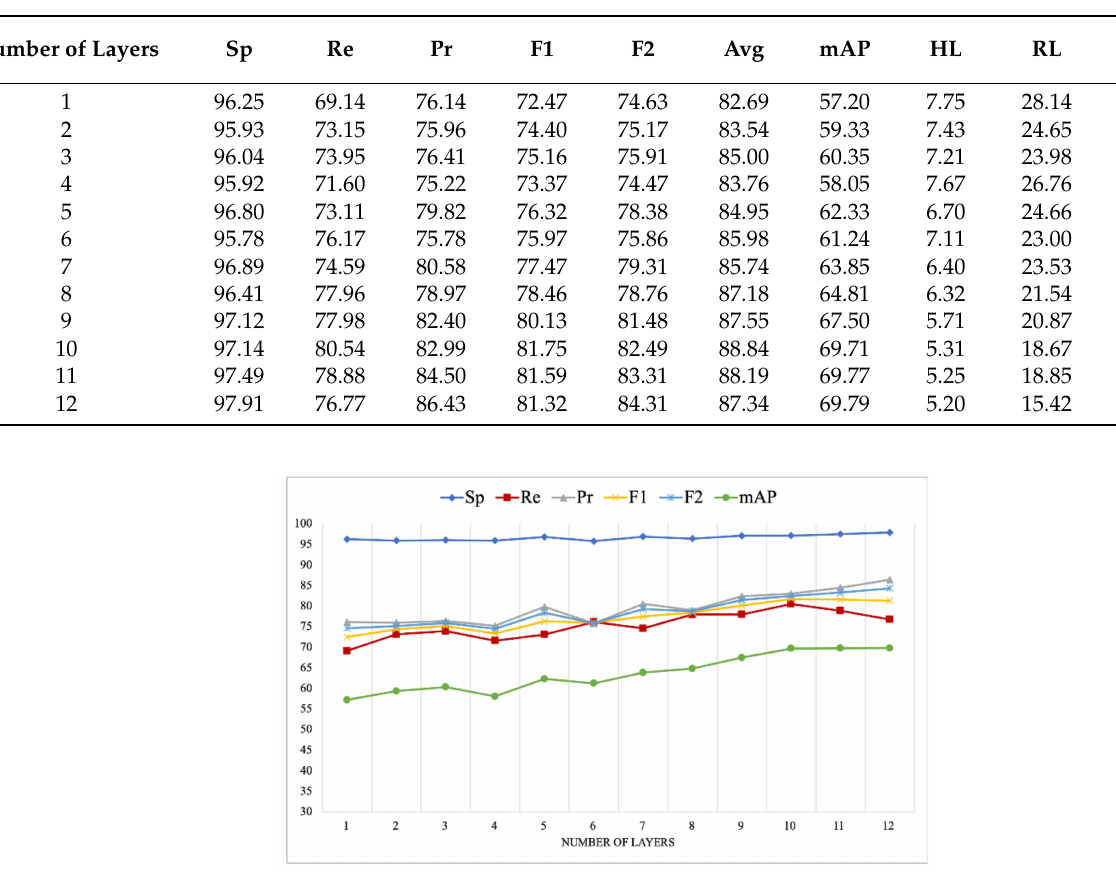
Figure 4. Results of our model on the Trento multi-label dataset. Table 5. Results of the Civezzano multi-label dataset.